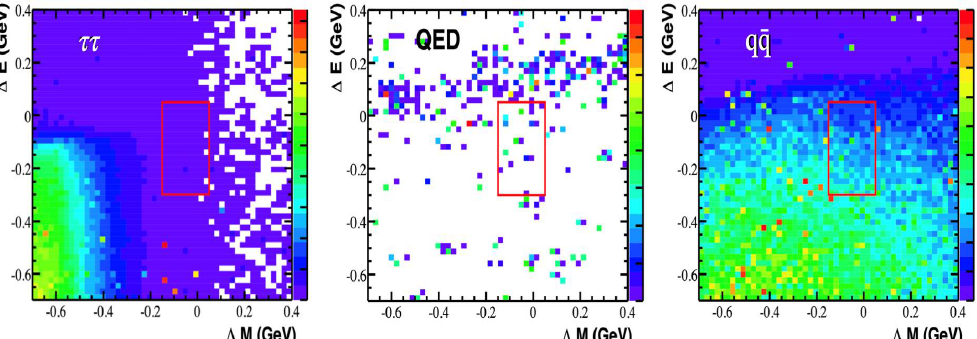
Figure 5. Two-dimensional distributions for ττ , QED, and q ¯ q background processes in the ( ∆ M , ∆ E ) plane obtained from simulated samples during analysis strategy development studies for τ − → µ − µ + µ − search at the B A B AR experiment [76]. Rectangular box-shaped regions mostly populated by the signal processes are shown in